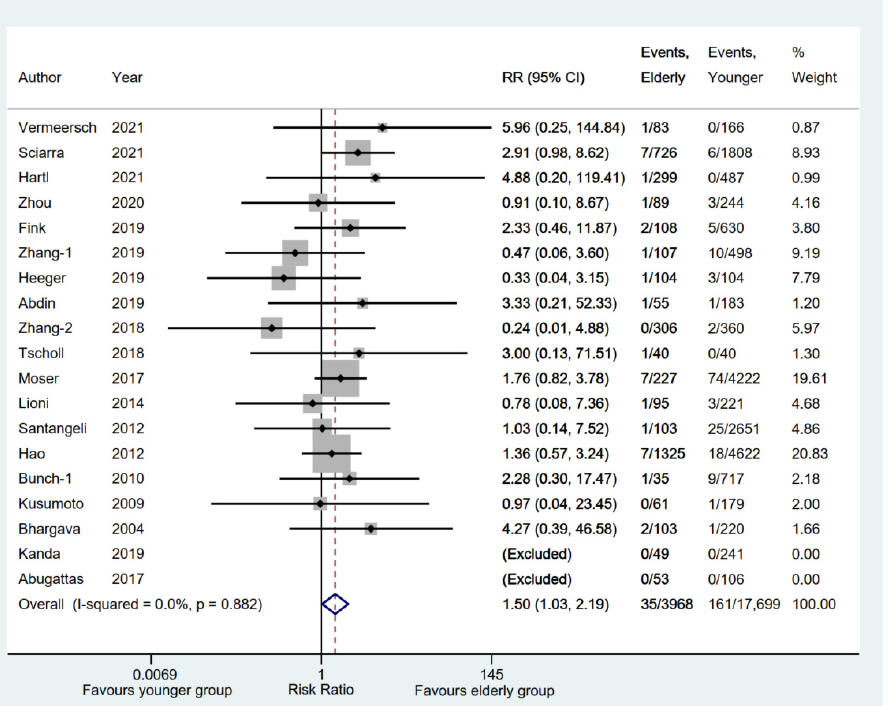
Figure 8. Forest plot comparing serious hemorrhage complications between elderly and younger groups [6,11–17,19–23,26–31]. The dotted red line represents the pooled risk ratio for serious hemorrhage complications between elderly and younger groups.